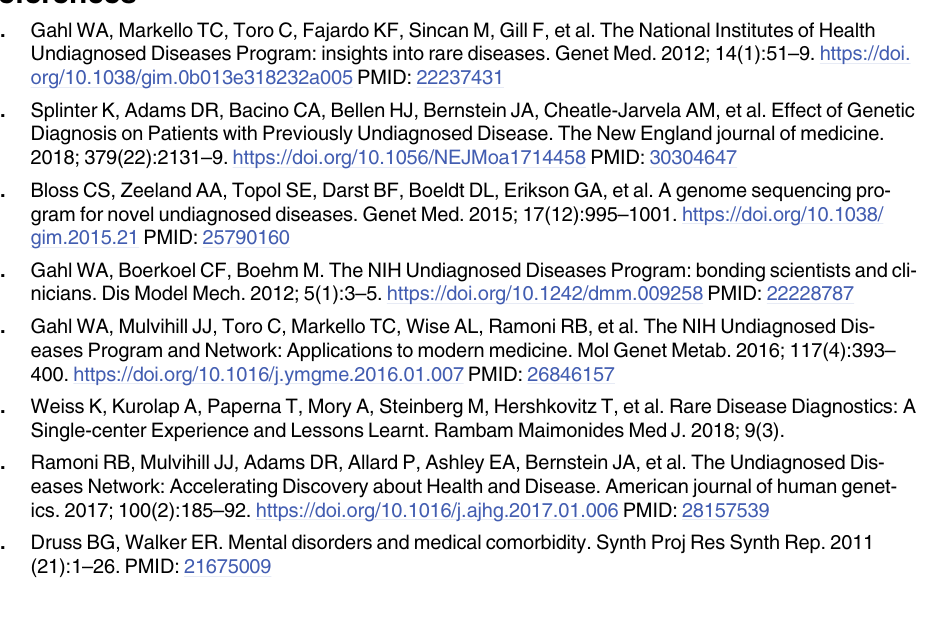
S1 Table. ICD-10 final diagnosis categories for n = 247 emory special diagnostic service patients. S2 Table. Psychiatric symptoms/diagnoses at intake for n = 247 emory special diagnostic service patients. S3 Table. Details (beta coefficients, R 2 , and p-values) from regression analyses. (DOCX) S1 Dataset. Codebooks and data tables for all data underlying the reported means, medi- ans, variance measure, p values and regression